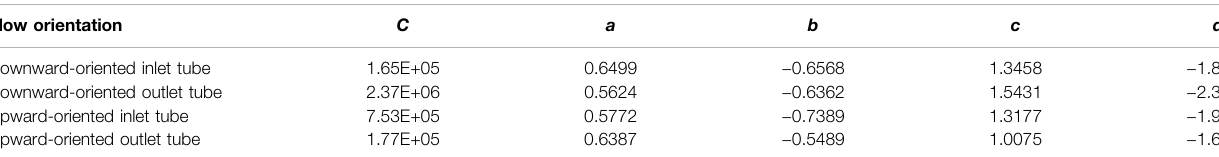
TABLE 3 | Values of parameters C , a , b , c , and d in Eq. 1 for different fl ow orientations and straight tube sections. Flow orientation